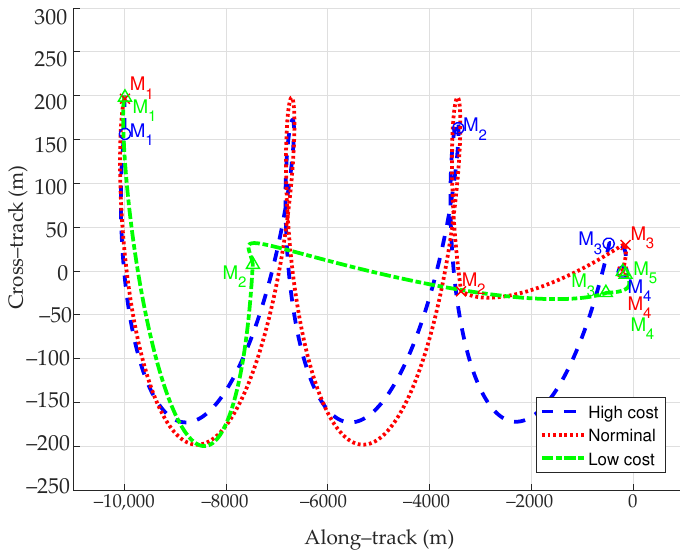
Figure 14. Optimal trajectories (out-of-plane) when t f =